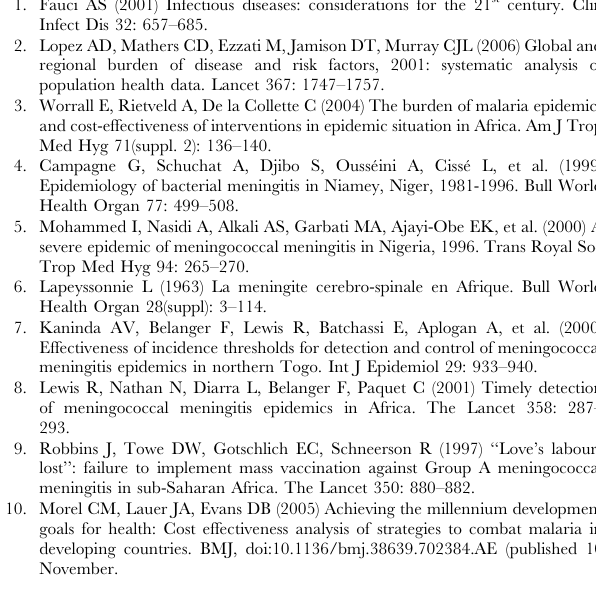
Table S5 Annual costs (in 2002 US $ ) of all public health-related surveillance and IDSR-related activities per category of resources and health structure level in Burkina Faso: 2002 to 2005.